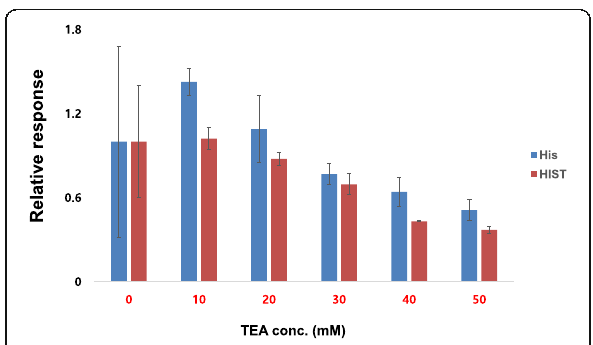
Fig. 4 Comparison of derivatization efficiencies in SGF: influence of HCl acceptor